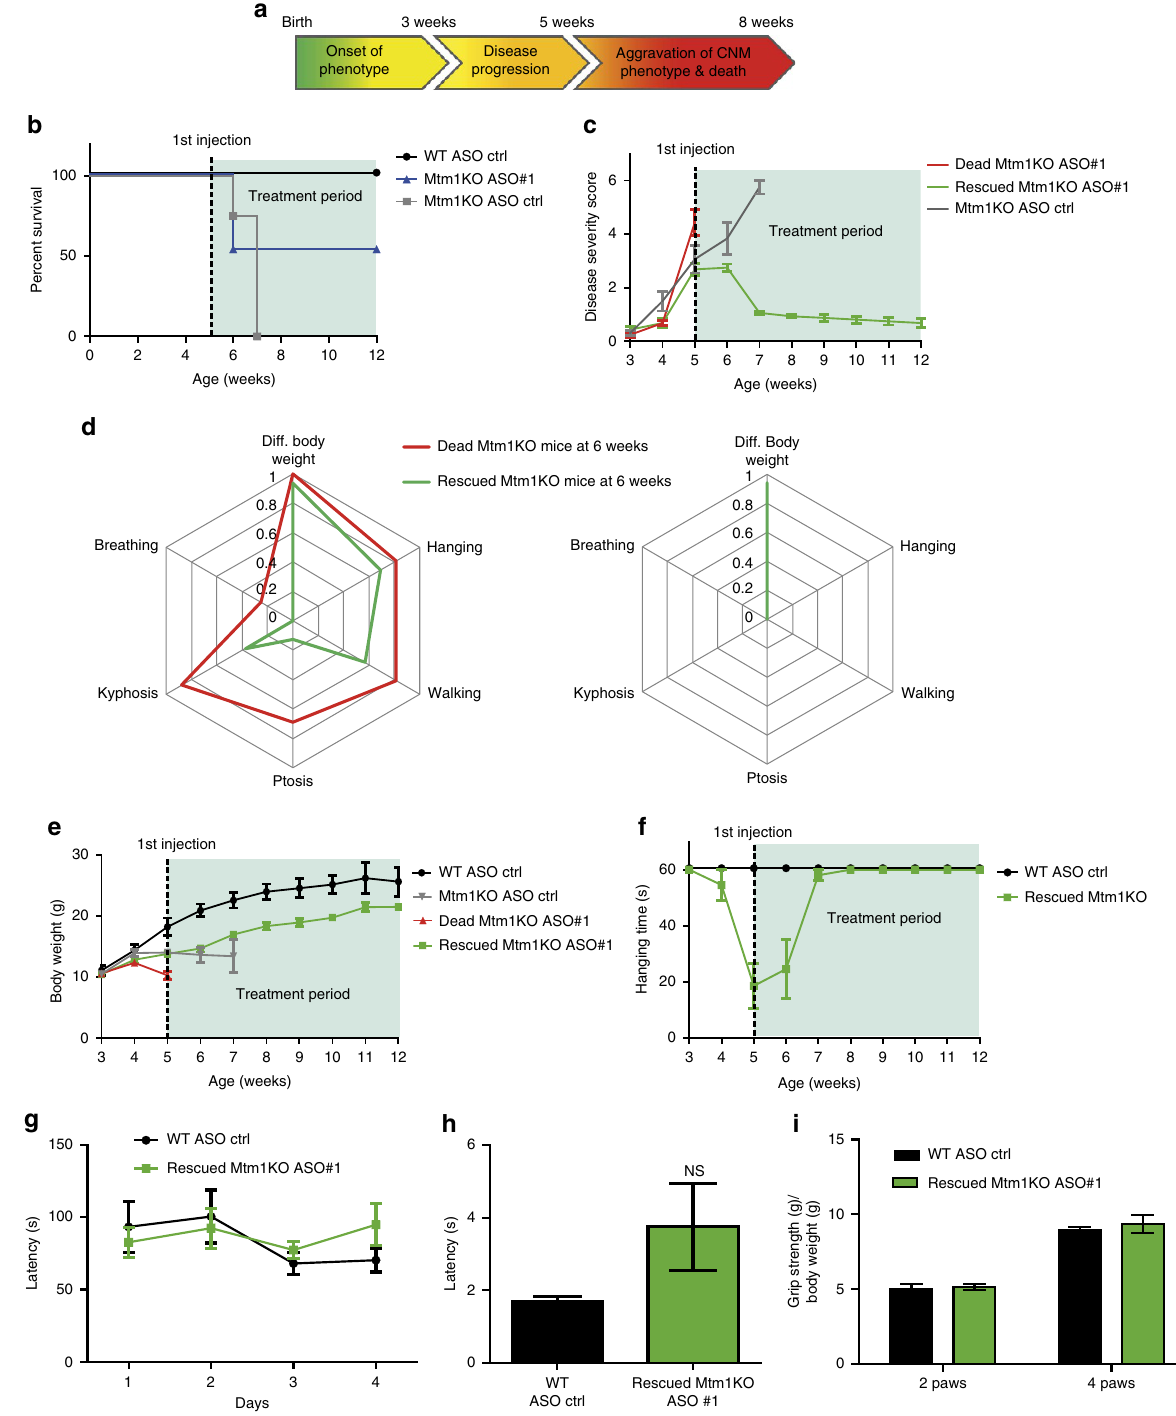
Figure 8 | ASO- Dnm2 systemic injections revert installed muscle defects in Mtm1KO mice. ( a ) Chronology of CNM phenotype onset and evolution in Mtm1KO mice. ( b ) Survival of WT ( n ¼ 5) or Mtm1KO ( n ¼ 16) mice upon ASO treatment started at 5 weeks. ( c ) Disease severity score (DSS) evolution of Mtm1KO mice that died during the first week of treatment or have been rescued after ASO treatment started at week 5. ( d ) Radar chart representing average values of the six main CNM features in Mtm1KO mice at 5 weeks old (before ASO treatment, left panel) and their evolution at week 12 (after 8 injections, right panel). ( e ) Body weight evolution of WT treated with ASO control ( n ¼ 5), Mtm1KO mice treated with ASO control ( n ¼ 8) or ASO#1 ( n ¼ 8 for dead or rescued Mtm1KO groups). ( f ) Hanging test performance of WT ( n ¼ 5) or Mtm1KO ( n ¼ 8) rescued by ASO treatment. ( g – i ) Clinical tests done at 11 weeks of age, WTor Mtm1KO mice underwent different clinical tests to assess whole body strength, fine motor coordination, balance and resistance to fatigue using rotarod ( g ), string test ( h ) and grip test ( i ). NS, not statistically significant ( t